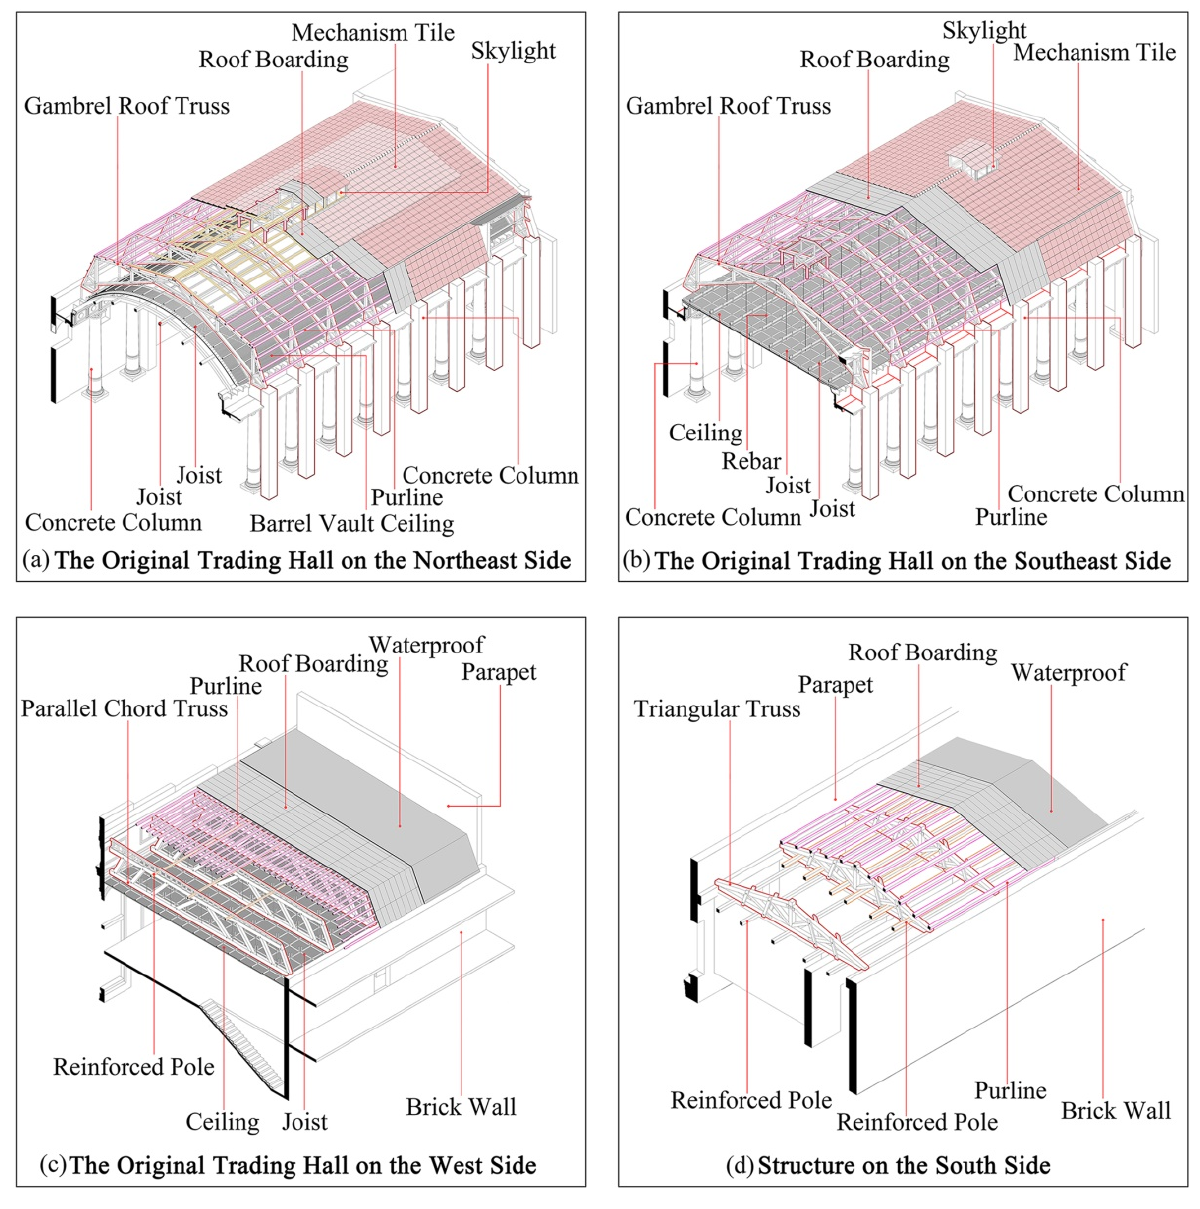
Figure 14. Analysis for the Roof Trusses.